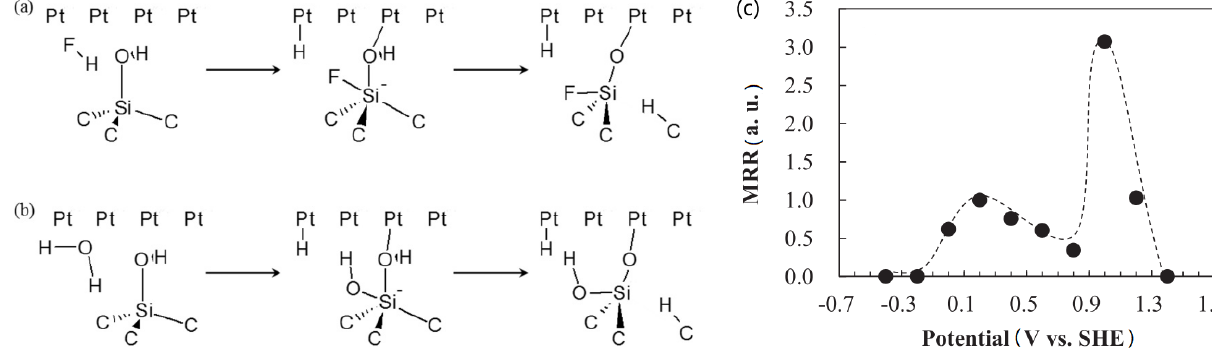
Figure 30. ( a ) Schematic of possible reaction pathways of ( a ) CARE with HF and ( b ) CARE with pure water; ( c ) dependence of relative MRR upon Pt potential [63].